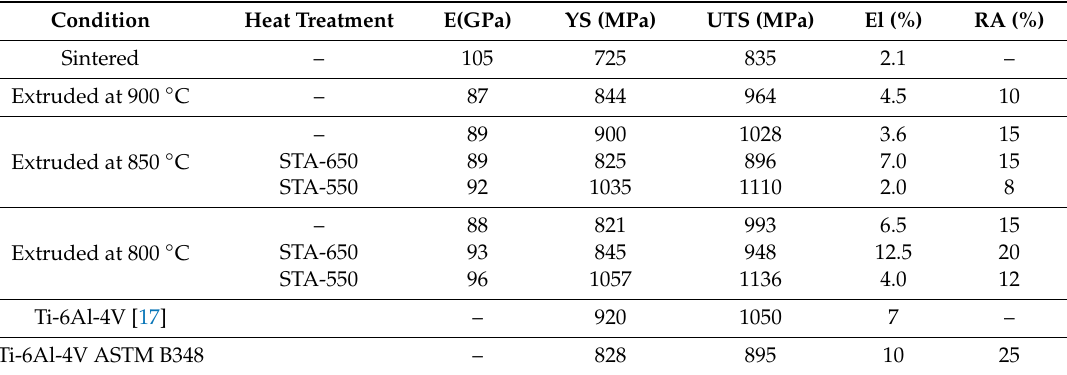
Table 2. Tensile Properties of the PM Ti-5Fe